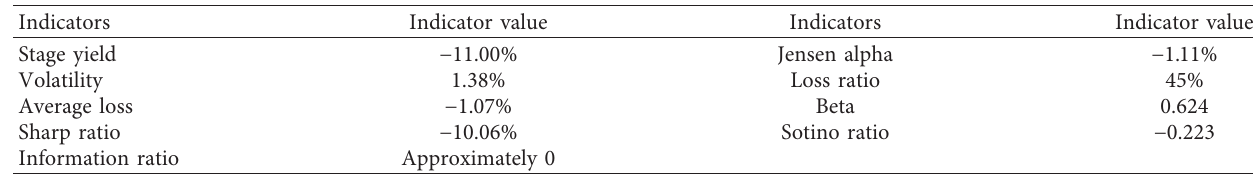
Figure 5: Scatter chart of return and VaR of fund companies. Table 1: Performance indicators of the fund.